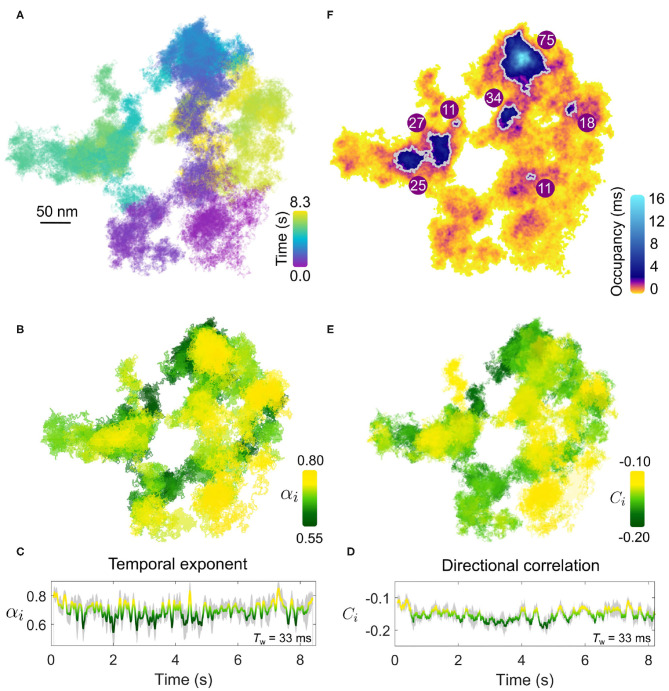
Confining patches within an anomalous walk. (A) The EGFR-GNP trajectory projected in x-y plane recorded at 30,000 fps over 8.3 s on a COS-7 cell. (B) The temporal exponent of diffusion is plotted for the trajectory as the color-scale over the trajectory showing the spatial distribution. (C) The temporal exponent of diffusion plotted as a function of time. (D) The directional correlation is also plotted as a function of time. (E) Directional correlation plotted over the corresponding position in the trajectory and time. (F) The density of trajectory points across the space of the trajectory is plotted as an ATOM map where color denotes the occupancy of each 2D areal bin of size 4 × 4 nm2. Patches of extra-ordinary occupancy are outlined in gray as a guide to the eye. The numbers plotted represent the equivalent circular diameter in nm of the outlined patches.